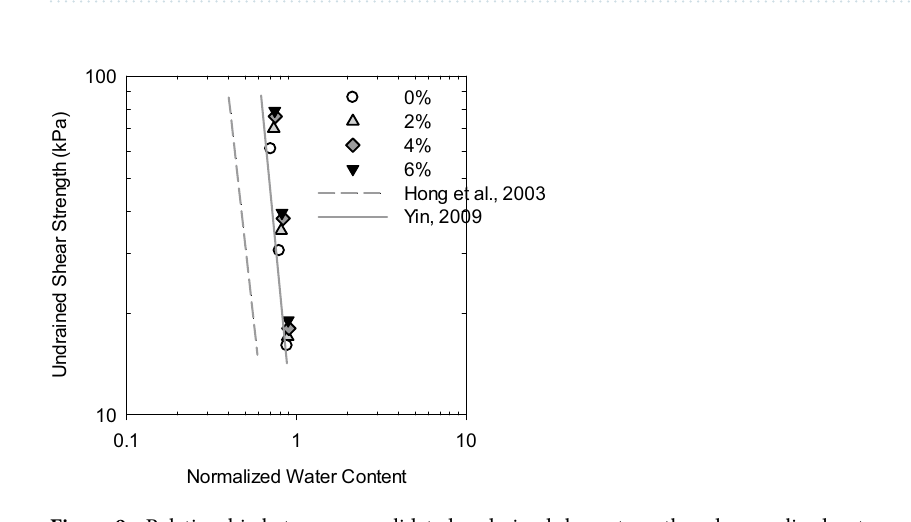
Figure 9. Relationship between consolidated undrained shear strength and normalized water content of soft marine clay with different